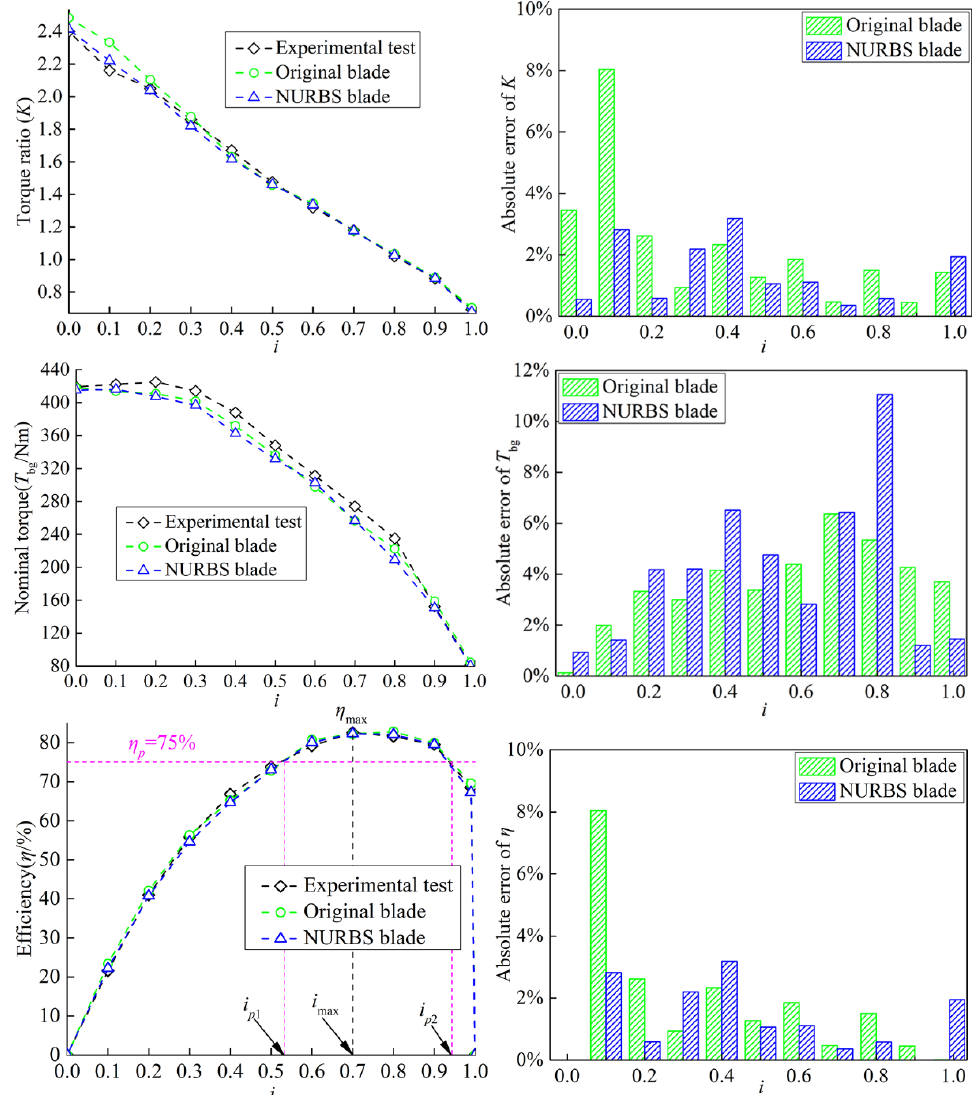
Figure 8. The comparison of hydrodynamic performances between the simulation and rig test.